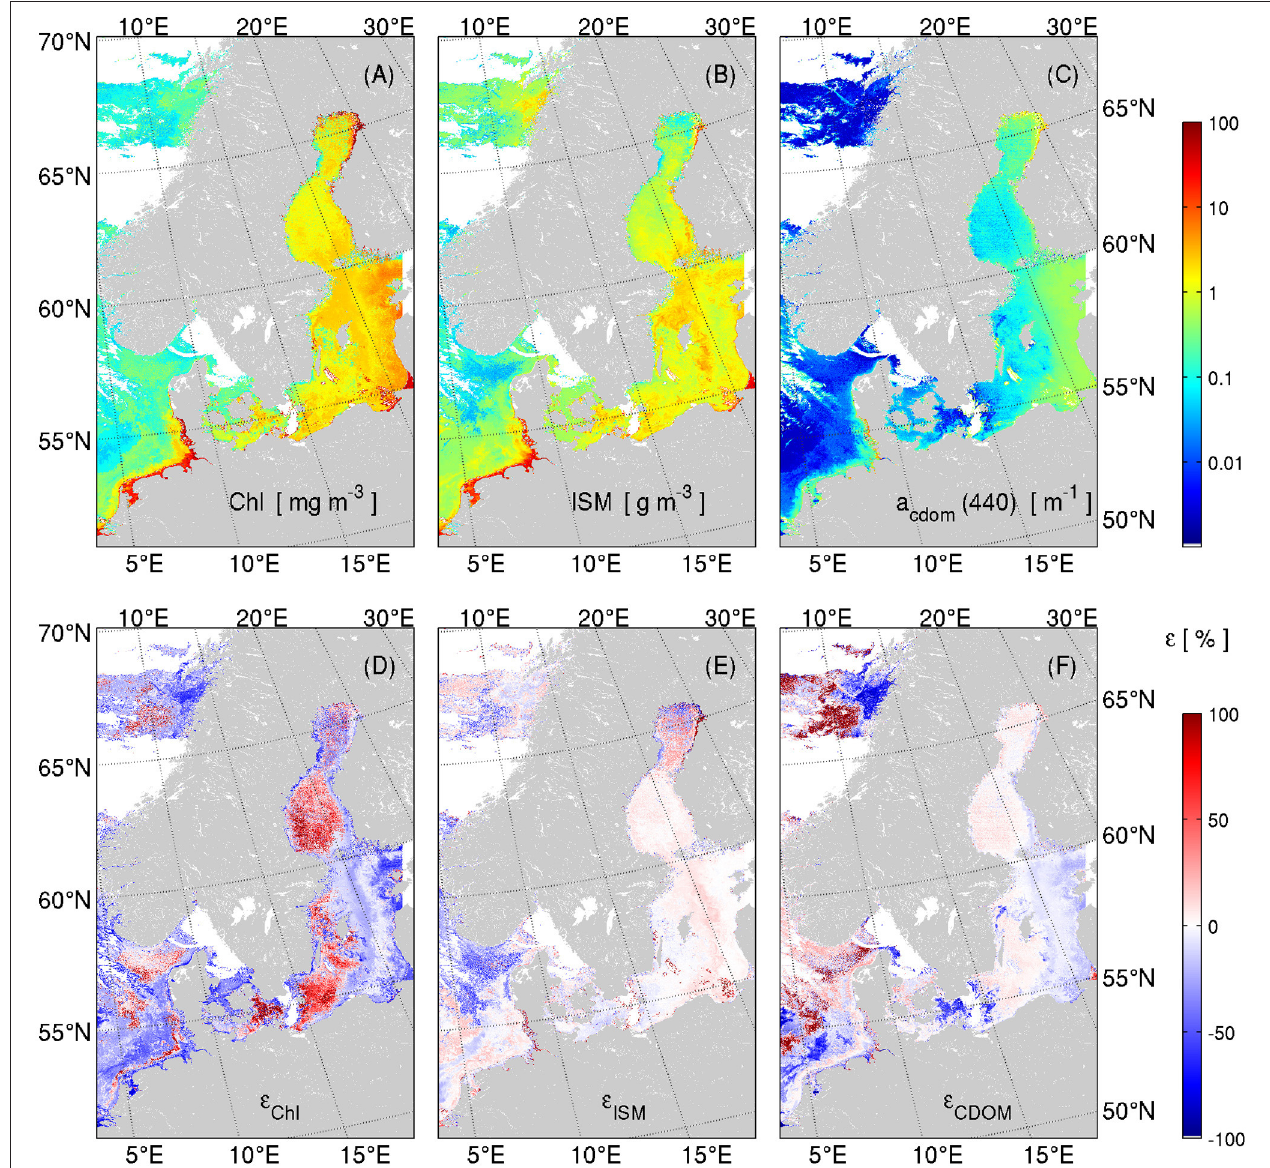
FIGURE 7 | ONNS application to the OLCI scene (20 July 2016, Figure 5). (A–C) : Upper panels show concentrations of chlorophyll, inorganic suspended matter, and CDOM (absorption coefficient at 440 nm). (D–F) : The panels below show the corresponding retrieval uncertainties. Land and clouds are masked